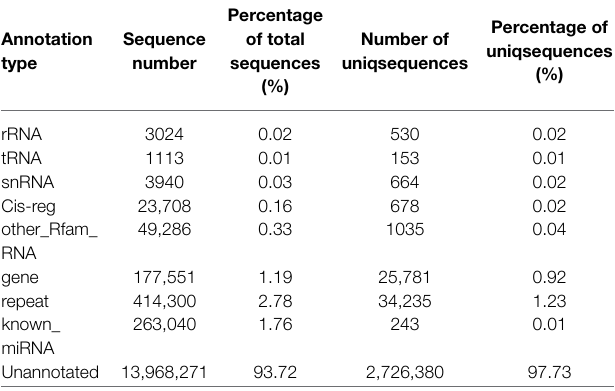
TABLE 2 | Sample read sequence types and